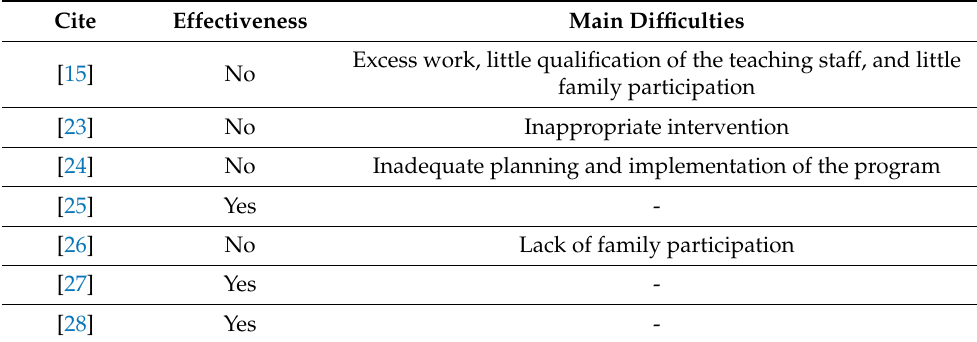
Table 4. Effectiveness of health promotion